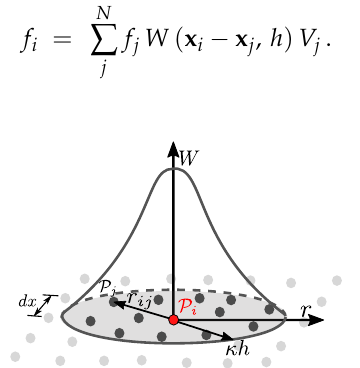
Figure 1. Representation of the kernel function W with compact support κ h and dependent on particle distance r ij